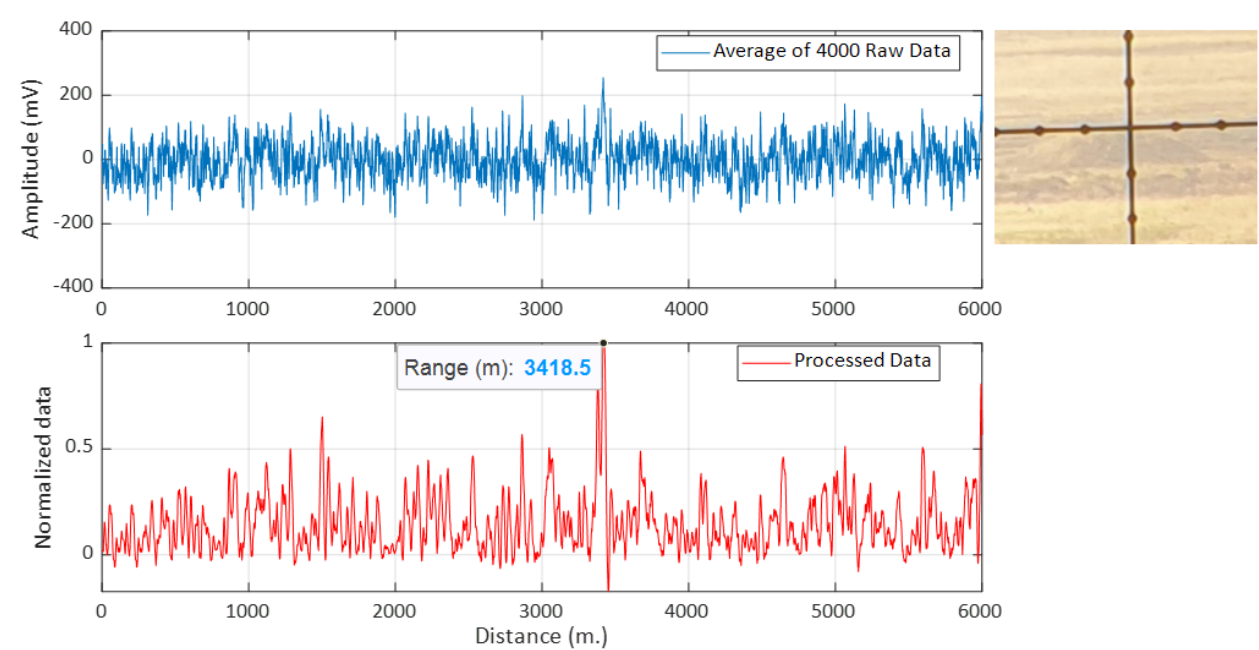
Figure 10. Average raw data ( top ) and processed data ( bottom ). The range found with our own LRF is 3418 m away from the LRF. The number of averaged raw data frame, N is 4000.